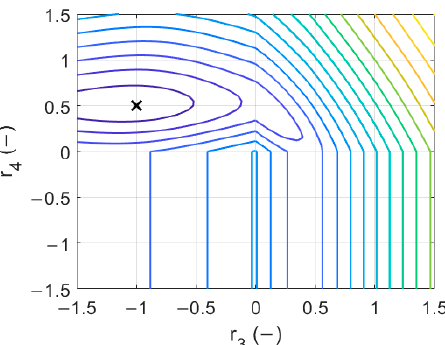
Table 5. Coefficients values. Figure 12. Error function in the sought parameters ( 𝑟 (cid:2871) and 𝑟 (cid:2872) ) space. The location of the optimal value is marked with ‘x’.